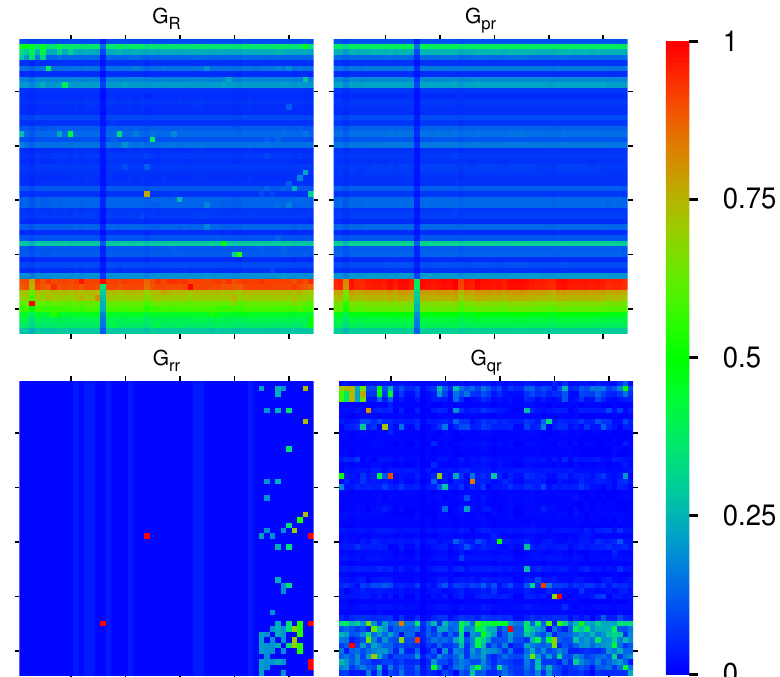
Figure 2. Color density plots of the matrix components G R , G pr , G rr , G qr for the group of Table 1; the x -axis corresponds to the first (row) index (increasing values of K g ) from top to down) and the y -axis corresponds to the second (column) index of the matrix (increasing values of K g from left to right). The outside tics indicate multiples of 10 of K g . The numbers in the color bar correspond to with g being the value of the matrix element and g max being the maximum value. In order to increase the visibility for the cases of G R , G rr , G qr , the maximum value has been reduced (saturated) to the value of the third largest value of g for each case, and the cells corresponding to the first and second largest values are reduced to the saturation value. In particular, G R ( 45,15 ) ( G R ( 46,13 ) ) has been reduced from 0.876387 (0.297512) to G R ( 49,3 ) = 0.208777; G rr ( 45,16 ) ( G rr ( 29,24 ) ) has been reduced from 0.850004 (0.121432) to G rr ( 29,54 ) = 0.019322 (same third value also for the other three cells in column 54); G qr ( 49,3 ) ( G qr ( 40,41 ) ) has been reduced from 0.240629 (0.062024) to G qr ( 46,32 ) = 0.041108. For the matrix G qr , there are some negative values, and here, we show their absolute values (see